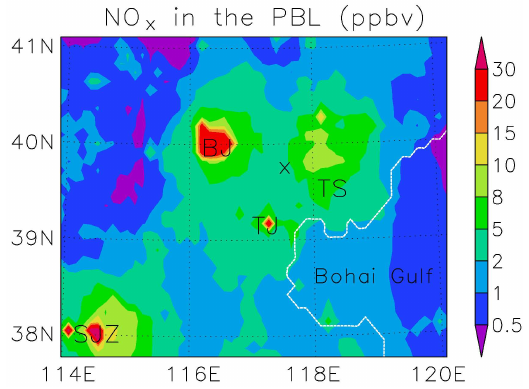
Fig. 3. RCTM simulated NO x mixing ratios in the planetary bound- ary layer (PBL) during IPAC-NC. The model predicts large regions with enhanced NO x around Beijing (BJ), Tianjin (TJ), Tangshan (TS) and Shijiazhuang (SJZ). The cross indicates the position of Xin’an